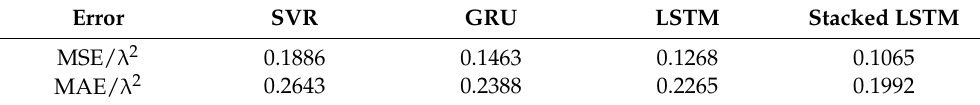
Figure 7. Line chart comparison of predicted data and actual data on different models: ( a ) line chart comparison of SVR predicted data and actual data; ( b ) line chart comparison of GRU predicted data and actual data; ( c ) line chart comparison of LSTM predicted data and actual data; ( d ) line chart comparison of stacked LSTM predicted data and actual data. Table 1. Mean square error and mean absolute error of PV on different modules.